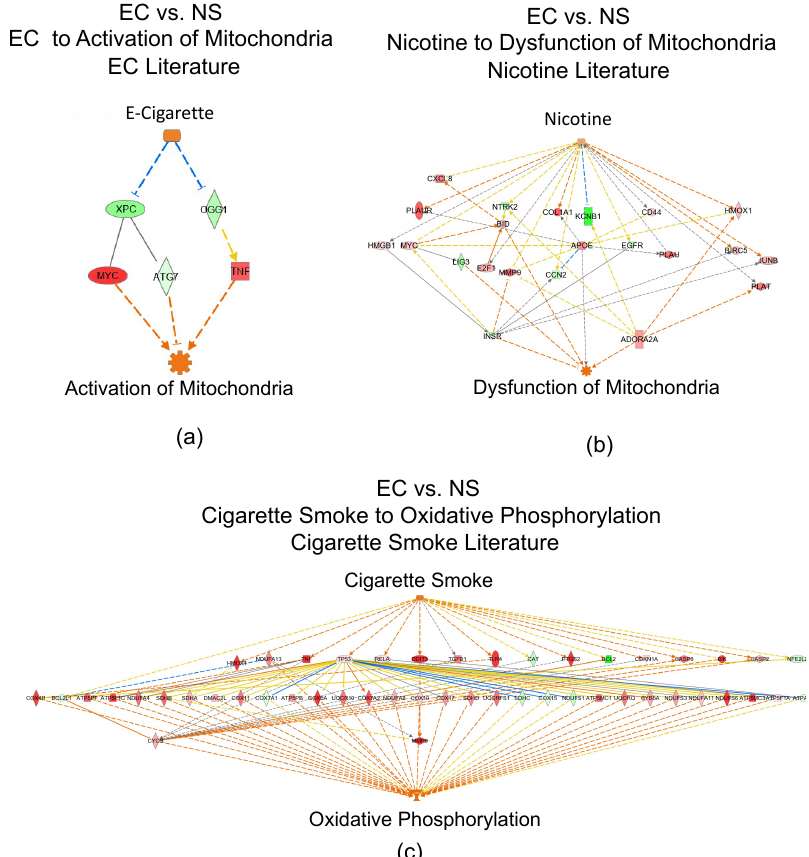
Figure 4. Mitochondrial pathways identified in the EC vs. NS set using IPA. ( a ) “Activation of Mito- chondria” generated by overlaying our data on the EC literature. ( b ) “Dysfunction of Mitochondria” generated by overlaying our data on the nicotine literature. ( c ) “Oxidative Phosphorylation” gen- erated by overlaying our data on the cigarette smoke literature. Upregulated DEGs are pink-to-red depending on fold-change, whereas green DEGs indicate downregulation. Orange arrows represent predicted activation, yellow arrows indicate non-consistent activation, and grey arrows represent effect not predicted. Images can be enlarged to read